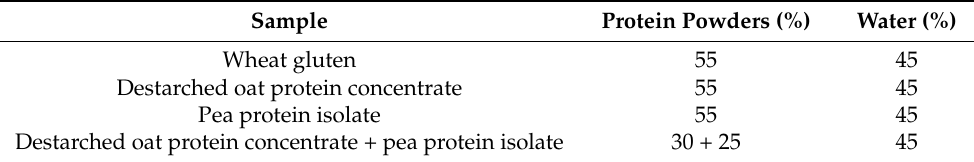
Table 1. The measured ratios of destarched oat protein concentrate, pea protein isolate, wheat gluten, and destarched oat protein concentrate with pea protein isolate for the closed cavity rheometer